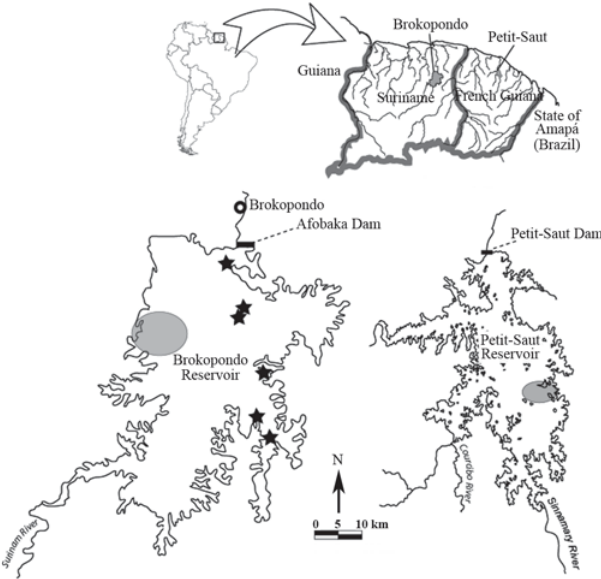
Fig. 1. Situation maps of the two reservoirs studied. Sampling areas are indicated by grey circles. Stars indicate additional samples in the Brokopondo Reservoir.